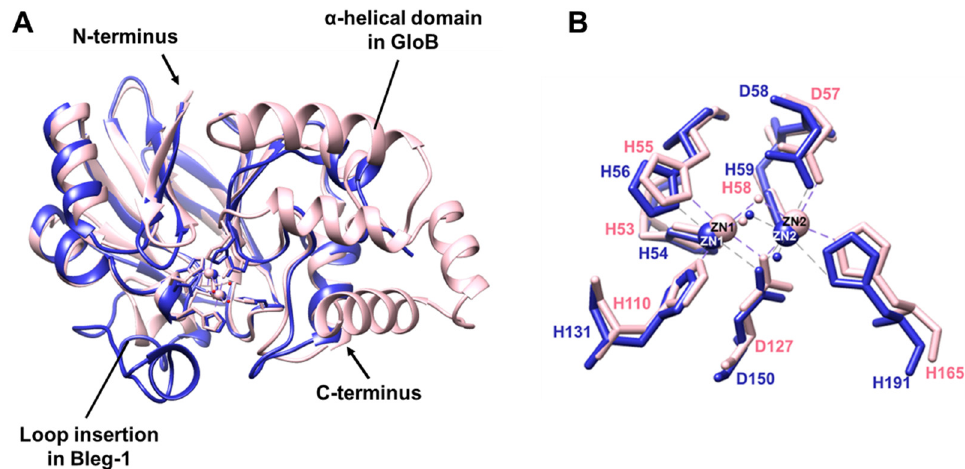
Figure 8. Superimposition of the ( A ) overall protein structure and ( B ) metal coordinating residues of BLEG-1 (blue) with GloB (PDB ID: 2QED, chain A) (pink).